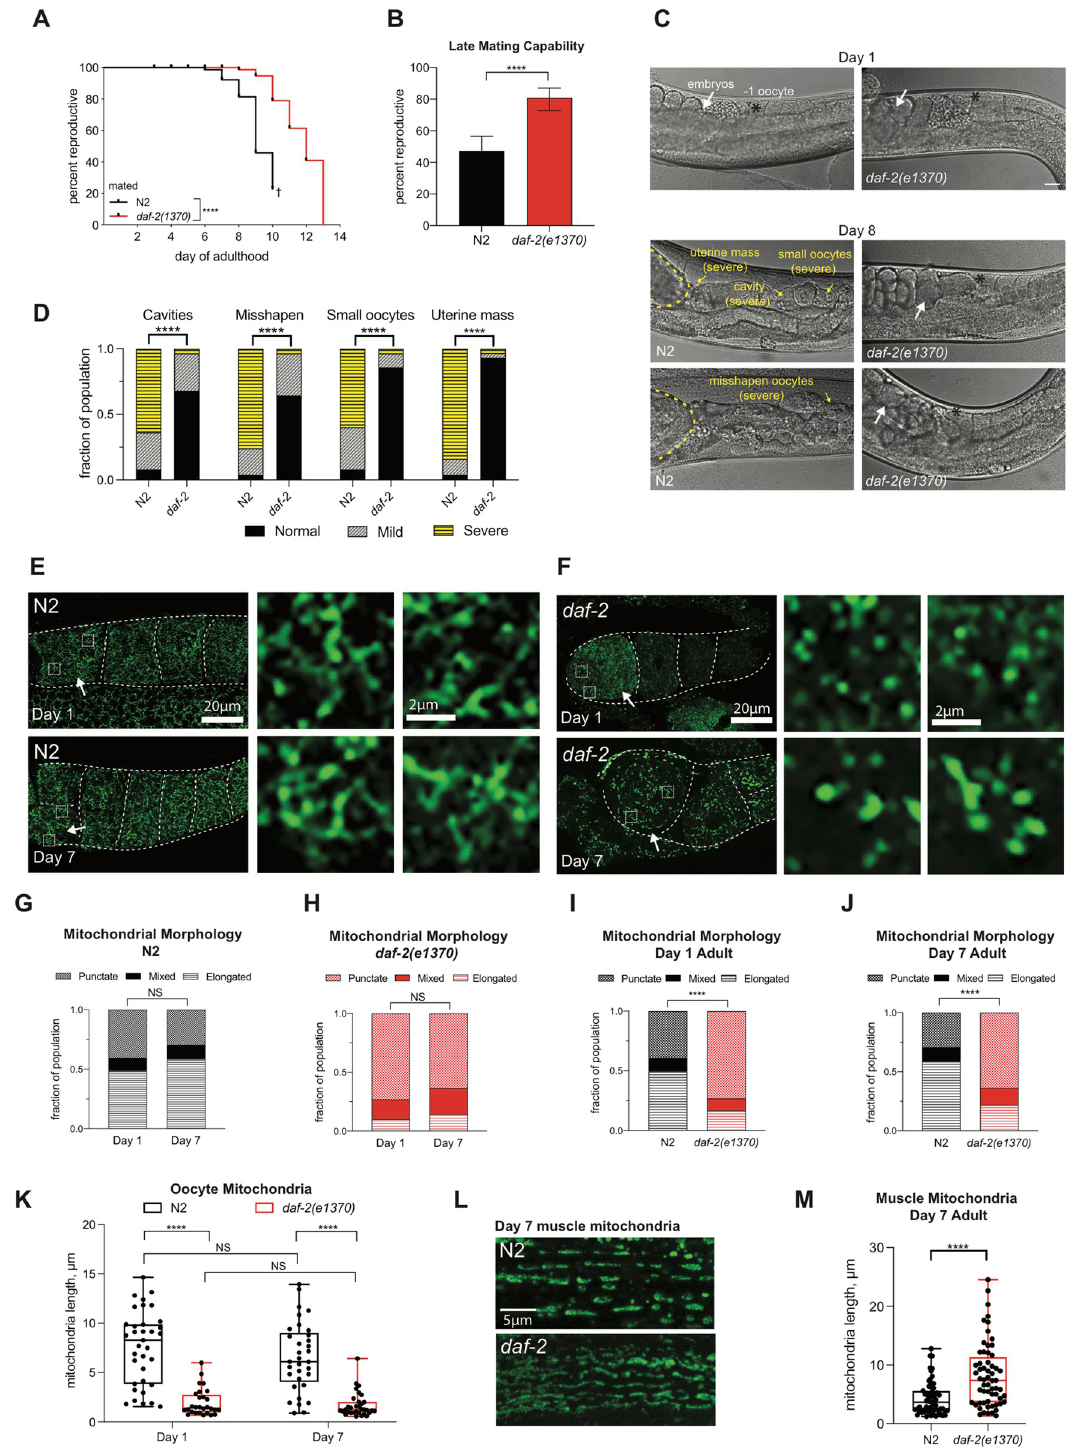
Fig 1. daf-2 oocytes display punctate mitochondria. daf-2 have an elongated reproductive span and maintain punctate morphology in oocyte mitochondria throughout reproduction. (A) daf-2(e1370) reproductive span in hermaphrodites (n = 96–121) mated with males (Luo et al. 2010). † indicates loss of hermaphrodites due to high rates of matricide by bagging. (B) daf-2(e1370) (n = 115) and N2 (n = 110) late-mating capability at Day 7 adult. Error bars represent 95% confidence interval. (C) Representative oocyte quality images. N2 (left panel) and daf-2(e1370) (right panel) at Day 1 and Day 8 adult. Black asterisks mark the -1 oocyte, white